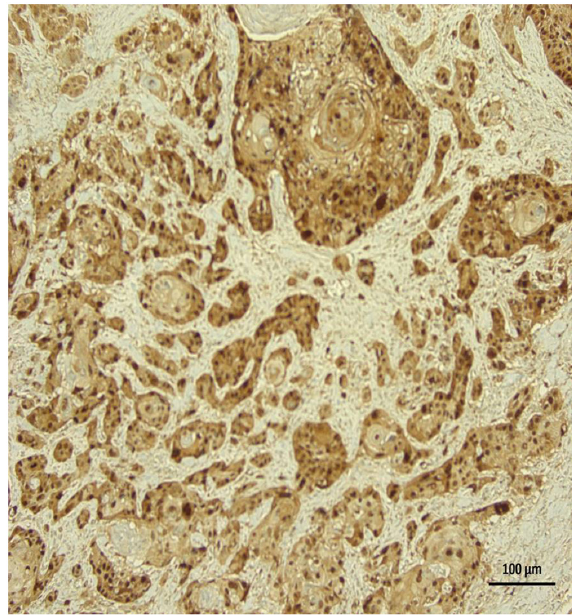
Figure 3. Heat shock-related 70-kDa protein 2 expression in infiltrative